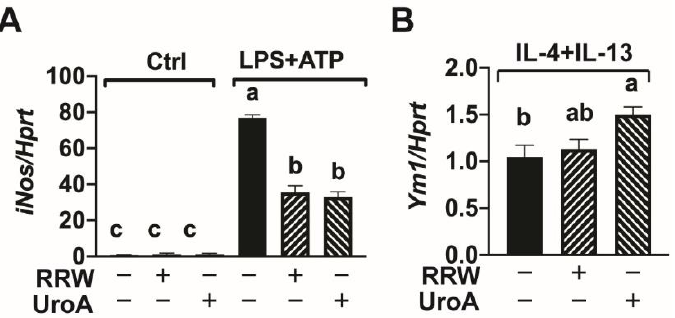
Figure 3. Urolithin A attenuated inducible nitric oxide synthase expression and promoted M2 microglial polarization. ( A ) BV-2 cells treated with LPS (500 ng/mL) for 3 h followed by ATP (2.5 mM) for 30 min with or without whole red raspberry polyphenols (10 µg/mL) or urolithin A (10 µM). Gene expression levels measured by RT-qPCR for iNos . ( B ) BV-2 cells treated with IL-4 (100 ng/mL) and IL-13 (10 ng/mL) for 24 h with or without whole red raspberry polyphenols (10 µg/mL) or urolithin A (10 µM). Gene expression levels measured by RT-qPCR for Ym1 . All values are represented as the mean ± SEM. Treatments with different letters indicate significant differences by one-way ANOVA, p < 0.05. IL = interleukin; LPS = lipopolysaccharide; RRW = whole red